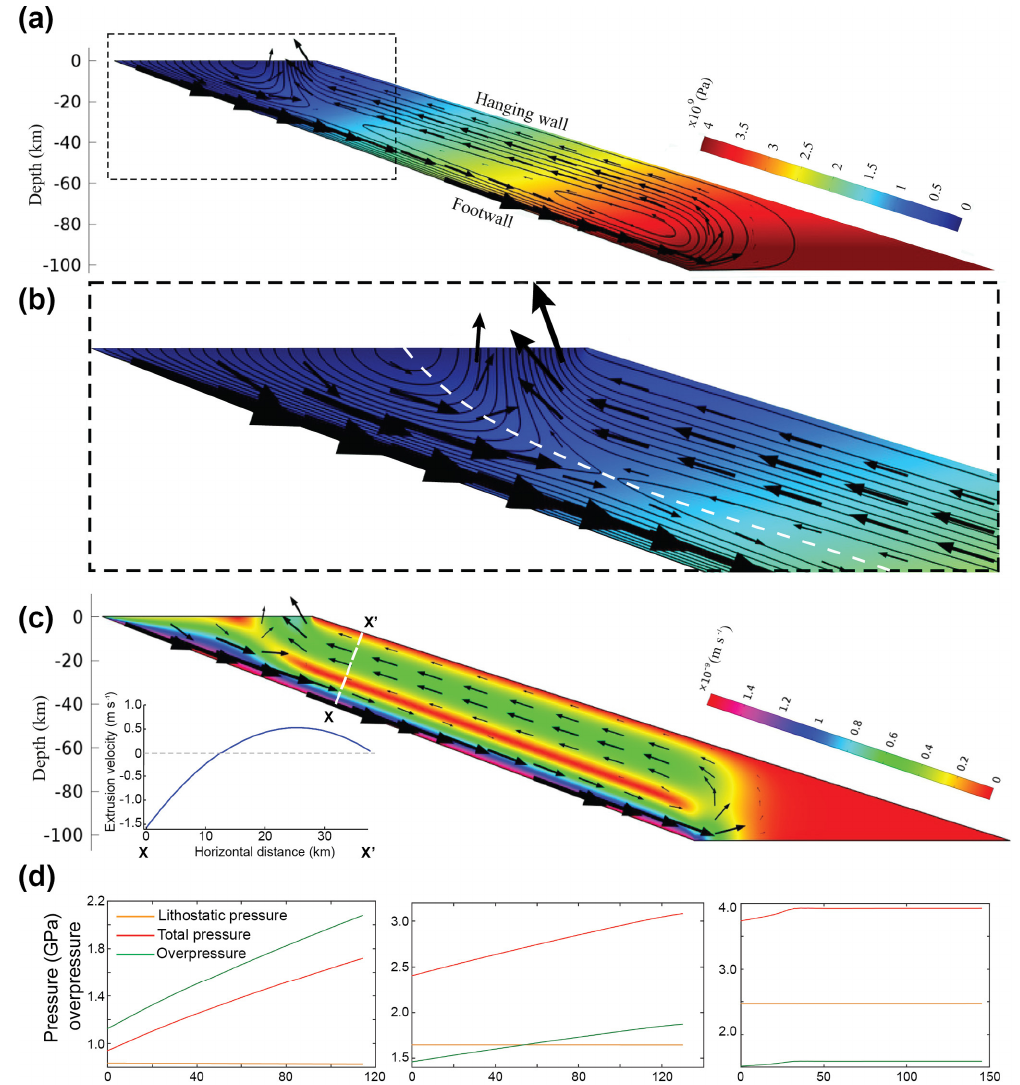
Figure 2. Pressure and velocity maps and graphs for a UTC with α = 20 ◦ , W m = 100km, W b = 150km, U = 4cmyr − 1 , and η = 10 21 Pas. (a) Velocity vectors and streamlines superimposed on pressure map (background colour and colour bar), where two distinct flow circuits can be recognized, one above and the other below − 30km. Also note asymmetry of flow relative to channel, with upward return flow concentrated nearest the hanging wall. (b) Zoom of the topmost domain of the channel (marked by dashed rectangle in a ). Note the convergence toward the surface between a shallow flow (mostly on the footwall side and carrying lower pressure and overpressure as seen in d ) and a deep flow (mostly on the hanging wall side and carrying higher pressure and overpressure as seen in d ). White dashed line separates downward and upward flows. (c) Velocity vectors superimposed on velocity coloured map (colour bar for scale). Note the red stripe of lower velocity closer to the footwall, which corresponds to the line of flow reversal in the model. Inset in (c) showing a velocity profile across the channel (marked by white dashed line and X − X (cid:48) ). (d) Graphs showing P, PL, and TOP = P / PL at − 30, − 60, and − 90km. Note that the highest overpressure occurs at the shallowest depth, and increases toward the hanging wall (except at −